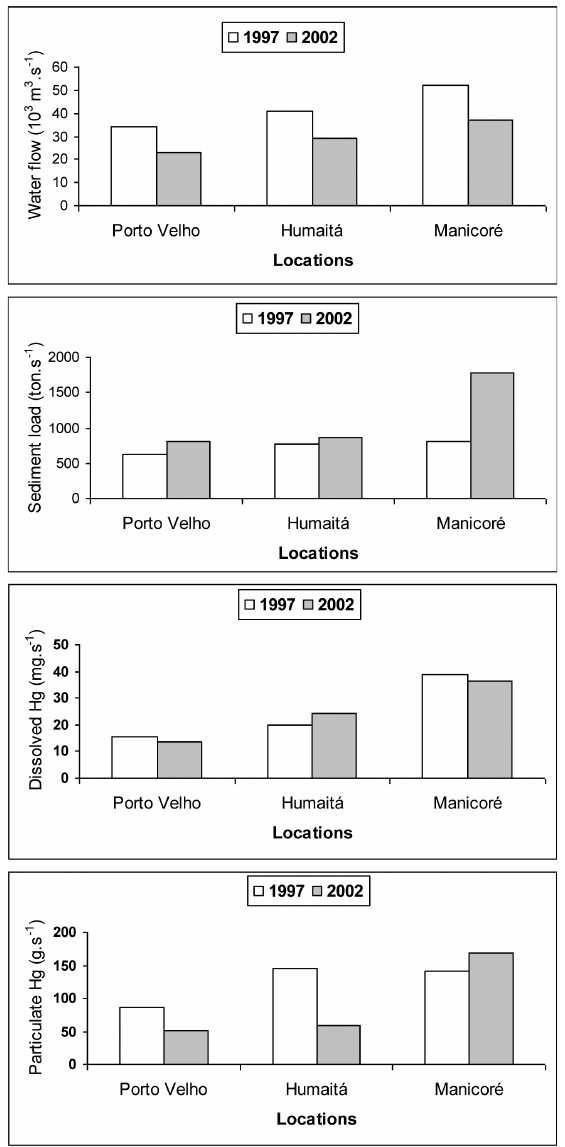
Figure 5. Instantaneous fluxes of water (m 3 .s -1 ), suspended solids (tons.s -1 ) and dissolved (mg.s -1 ) and particulate Hg (g.s -1 ) estimated for three different sectors of the lower madeira